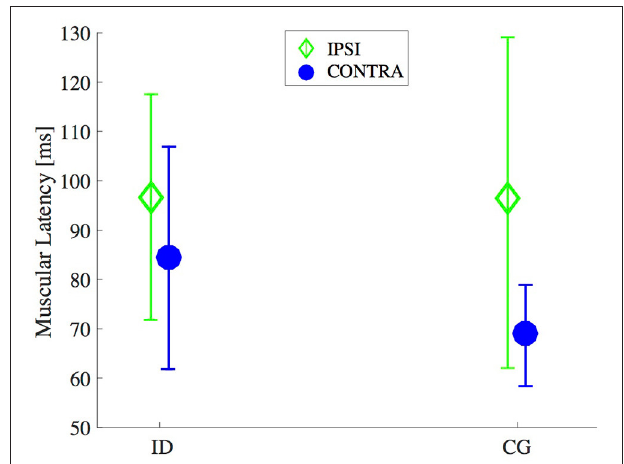
FIGURE 2 | Timing for muscle onset activation after an unexpected external perturbation. Mean and standard deviation of the latency of M. obliquus externus abdominis (CONTRA and IPSI sides) of individuals with intellectual disabilities (ID) compared with control group